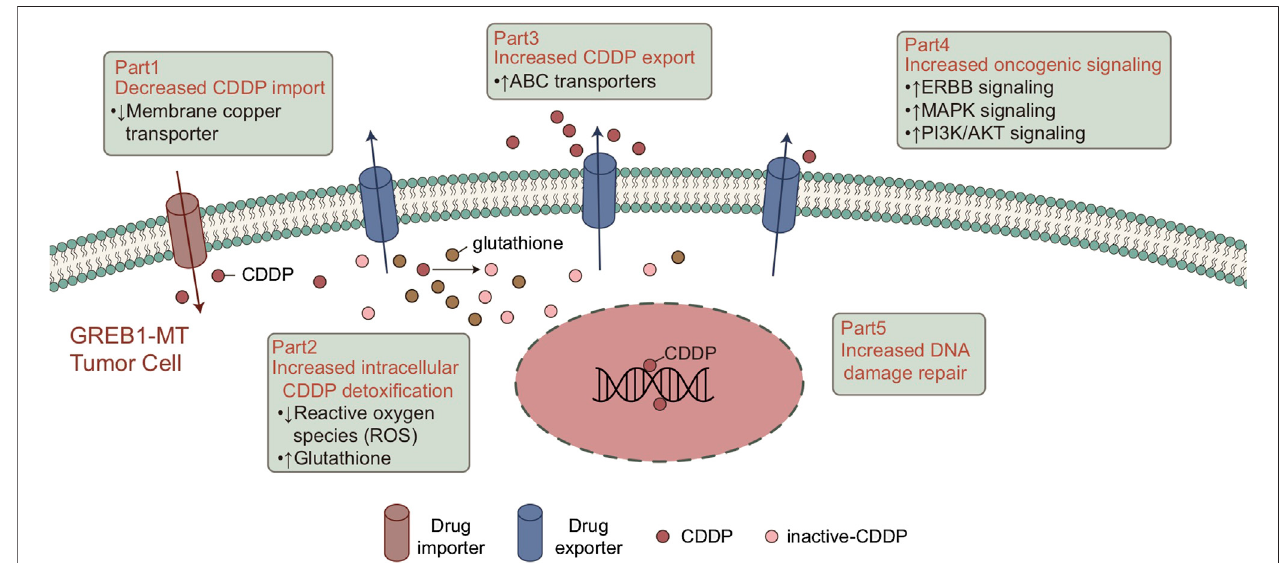
FIGURE 6 | Potential mechanism of GREB1 mutations mediating the resistance of CDDP in LUAD. CDDP, cis -diamminedichloroplatinum(II); LUAD, lung adenocarcinoma.